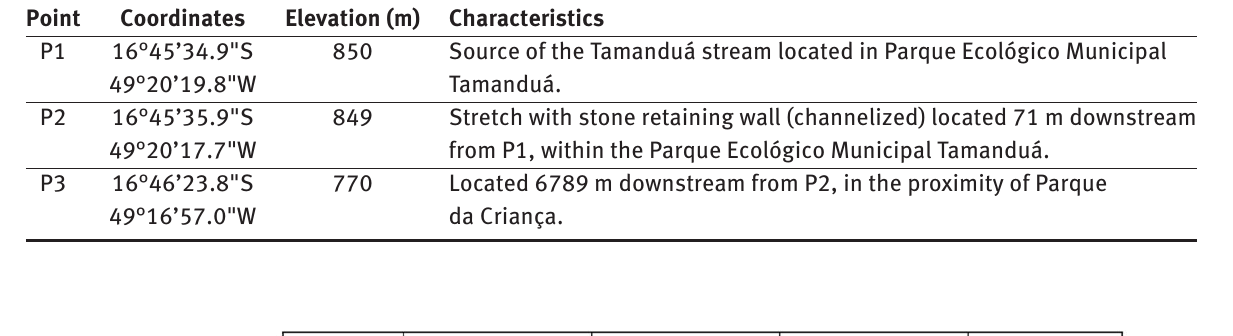
WQI B <40, inappropriate for 40 ≤ WQI B <50, normal